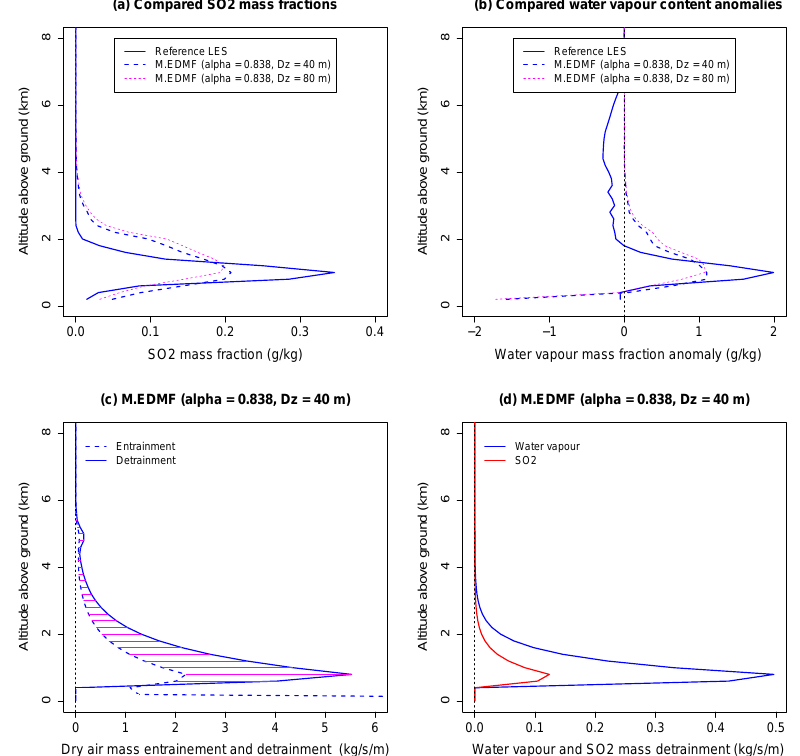
Figure 9. Results from the best-fitted SCM simulation with respect to the reference LES simulation (Fig. 6b). The best adjustment was found for δ = 0 in the first model layer and a value of entrainment ε such that the fraction of fresh ambient air entrained at the top of the first model layer is α = 0 . 838. (a) Compared SO 2 profiles in the SCM and LES. (b) Compared profiles of water vapour anomaly (defined as departure from the initial profile). (c) Profiles of dry air mass entrainment and detrainment rates ( εM u and δM u , respectively). Where detrainment dominates, the difference is shaded in magenta. (d) Profiles of water vapour and SO 2 mass detrainment ( δ [ H 2 O ] M u and δ [ SO 2 ] M u ,